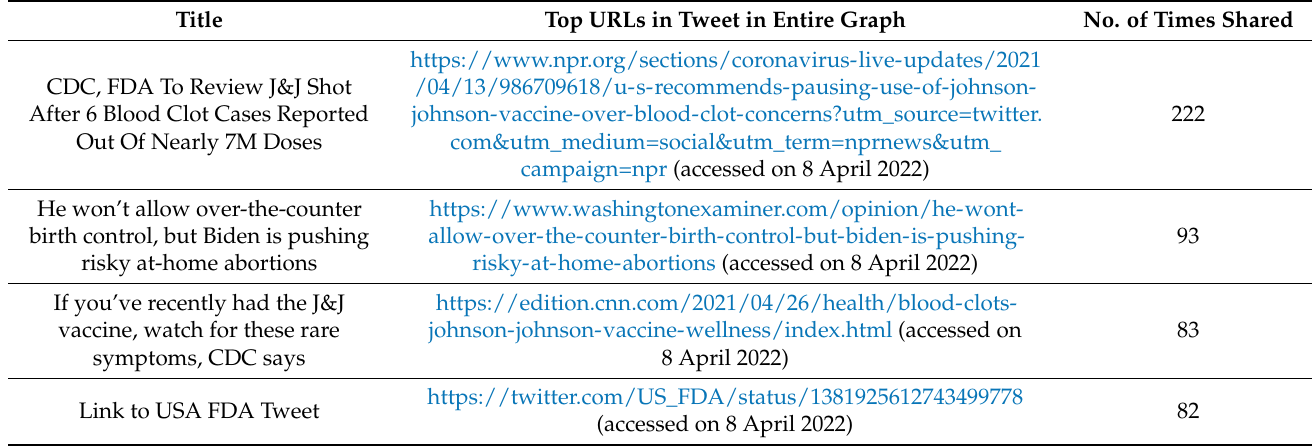
Table 1. Overview of key